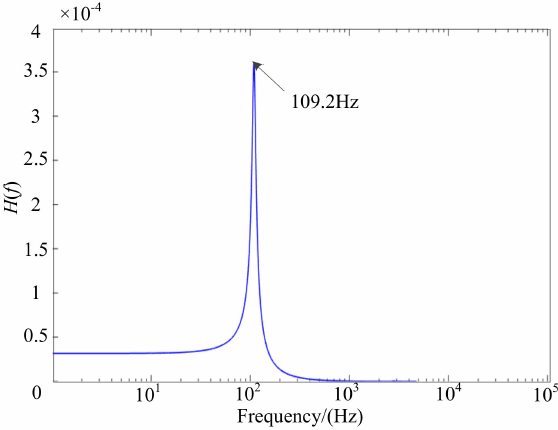
Figure 9. The frequency response of the one-degree freedom model of the plastic box.